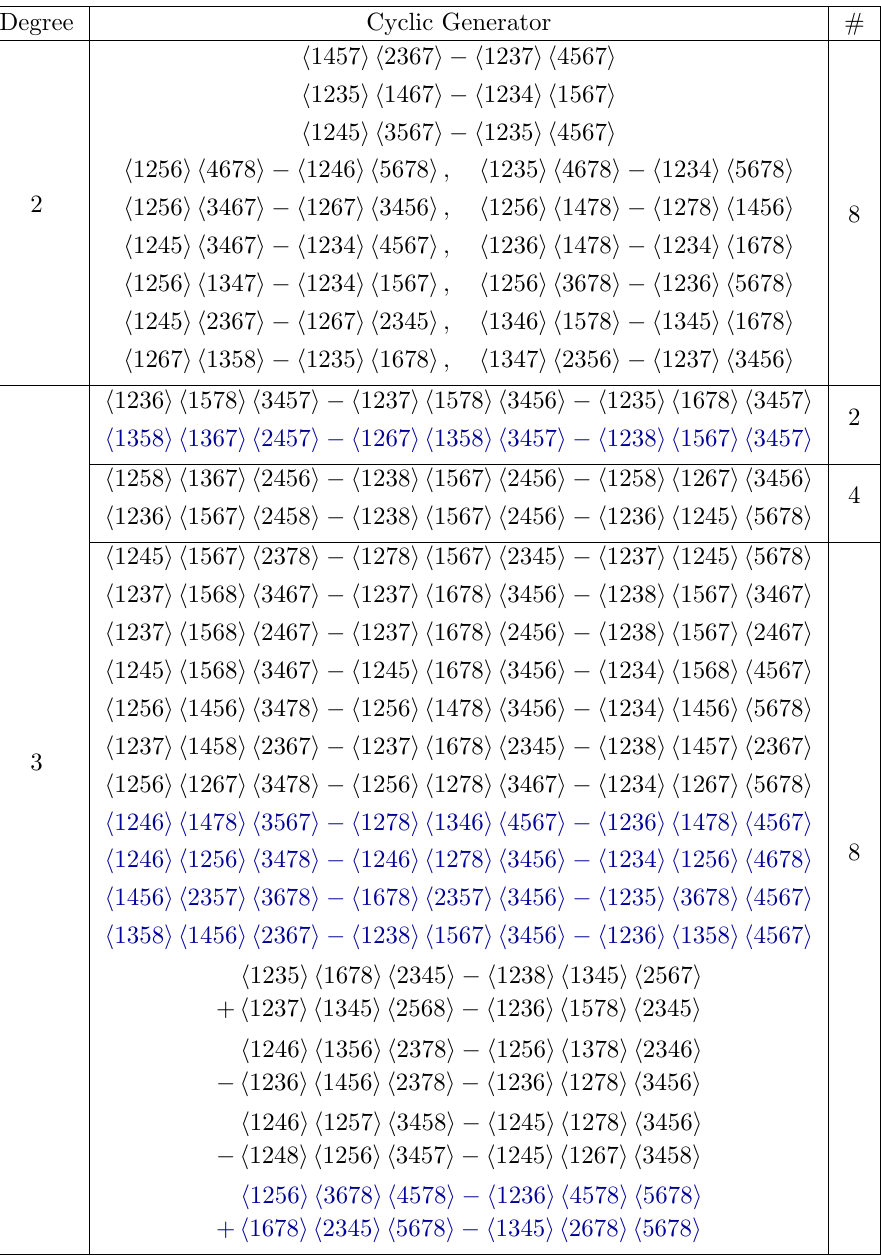
Table 5 . Cyclic generators of the eight-particle alphabet of degree 2 and 3. In the last column, the size of the cyclic orbit of each generator is given. The generators whose dihedral (cid:13)ip is not contained in the alphabet are highlighted in